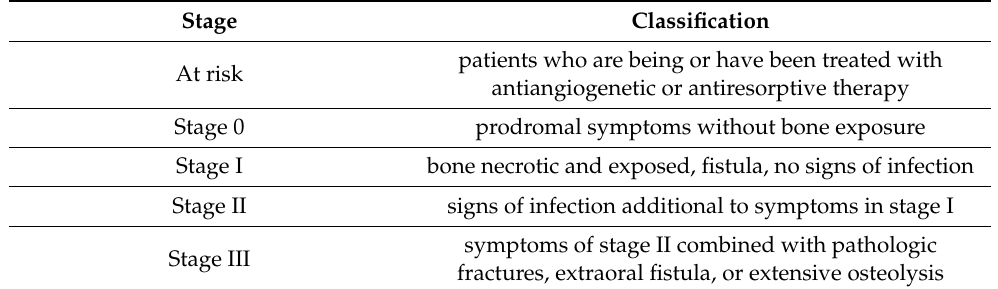
Table 1. MRONJ classification according to the American Association of Oral and Maxillofacial Surgeons. Stage Classification patients who are being or have been treated with At risk antiangiogenetic or antiresorptive therapy Stage 0 prodromal symptoms without bone exposure Stage I bone necrotic and exposed, fistula, no signs of infection Stage II signs of infection additional to symptoms in stage I symptoms of stage II combined with pathologic Stage III fractures, extraoral fistula, or extensive osteolysis Previous studies have reported a predominance of stages I and II MRONJ